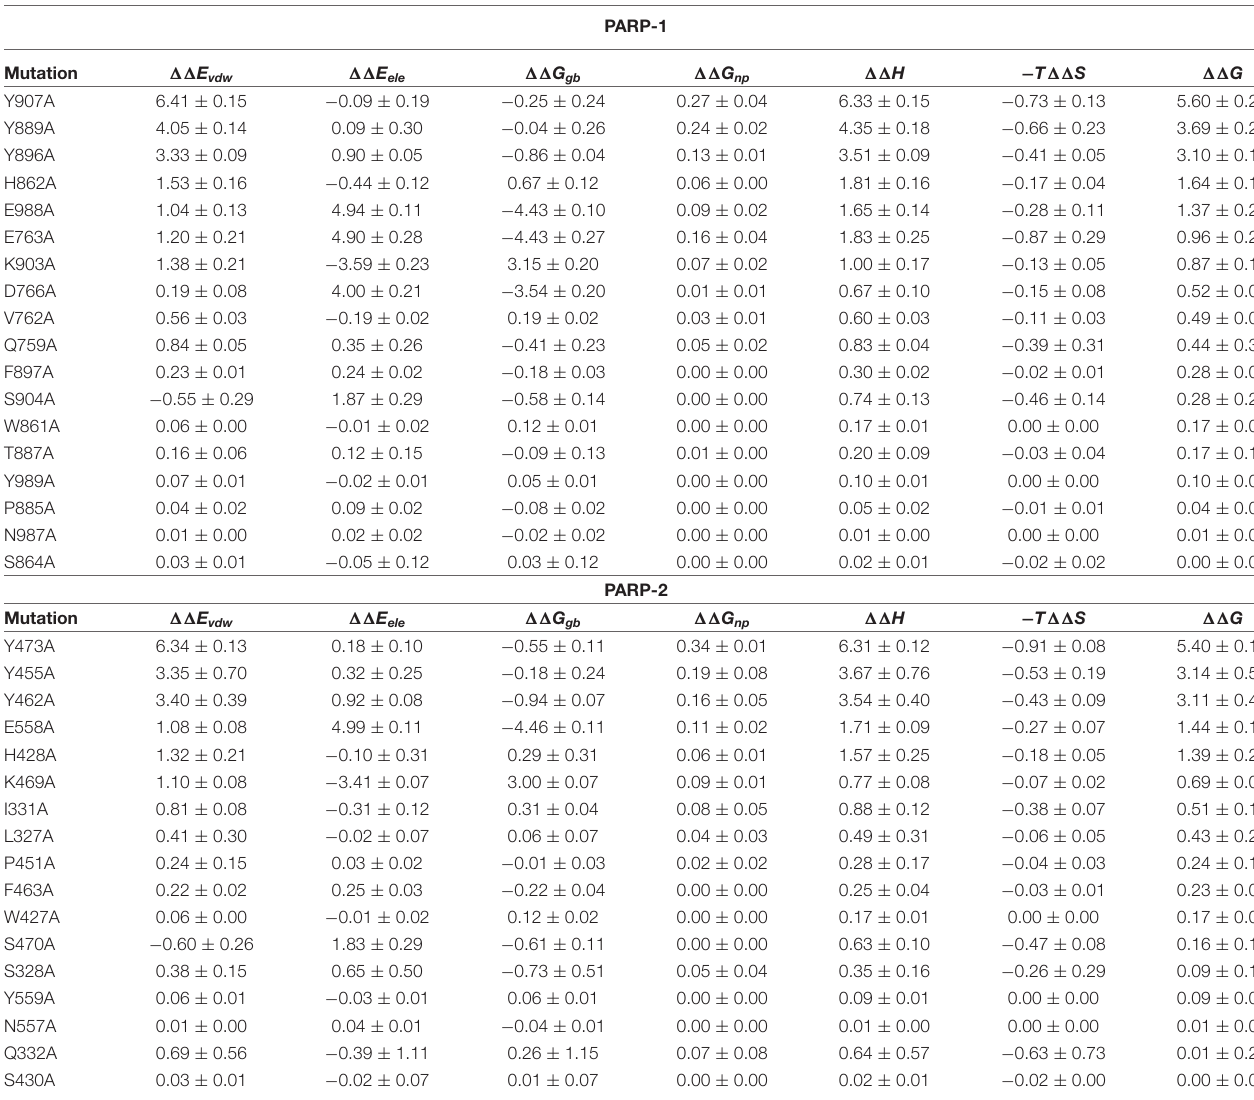
TABLE 2 | Computational alanine scanning for PARP-1 and PARP-2 with the MM/GBSA_IE method.